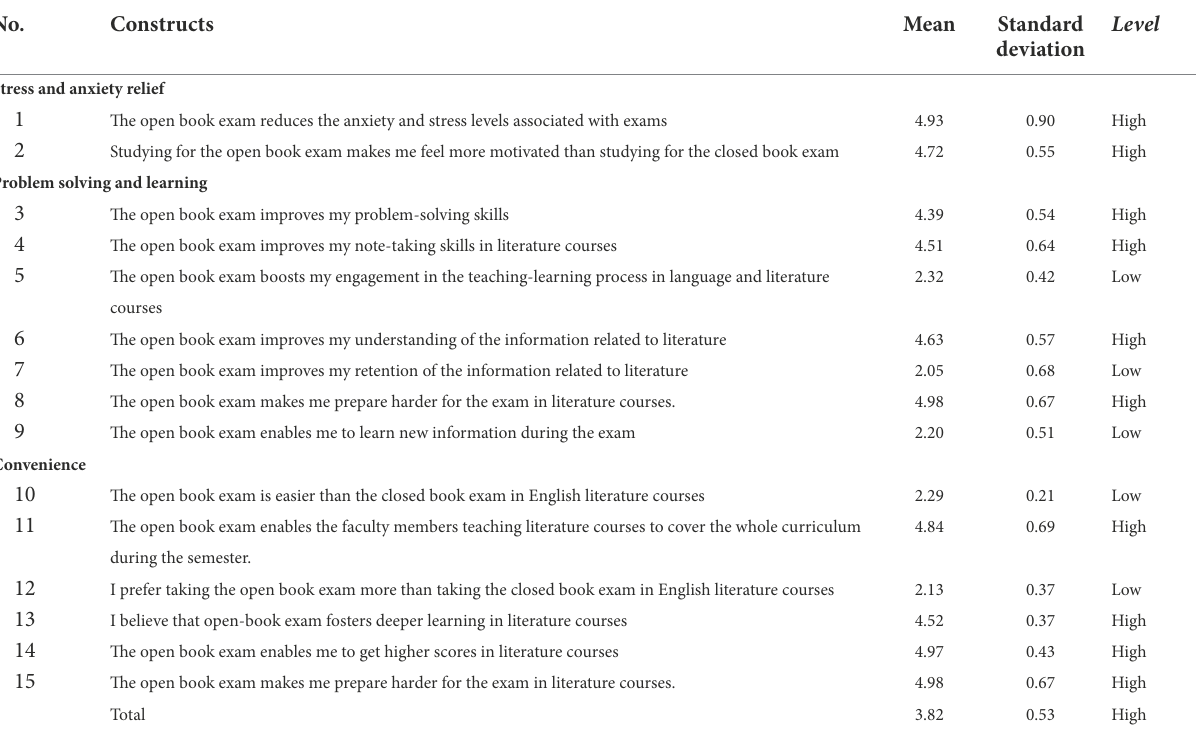
TABLE 3 The respondents’ attitudes toward open book